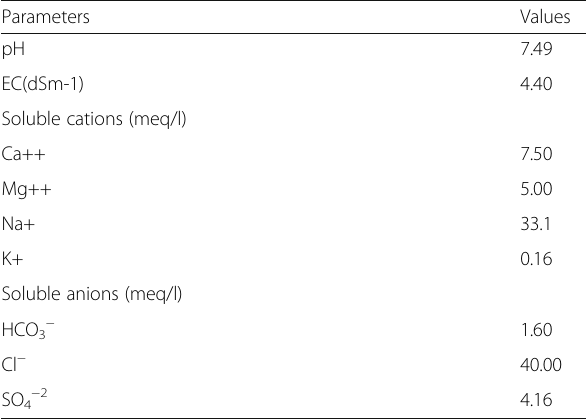
Table 2 Chemical characteristics of the irrigated water used in present study